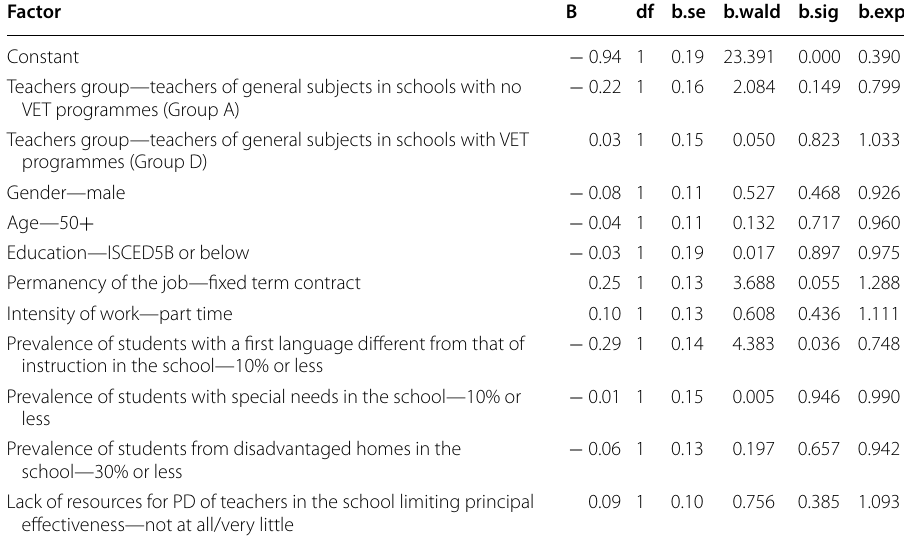
Table 16 Declaring high needs for professional development in the domain of students behaviour and classroom management, results of the logistic regression